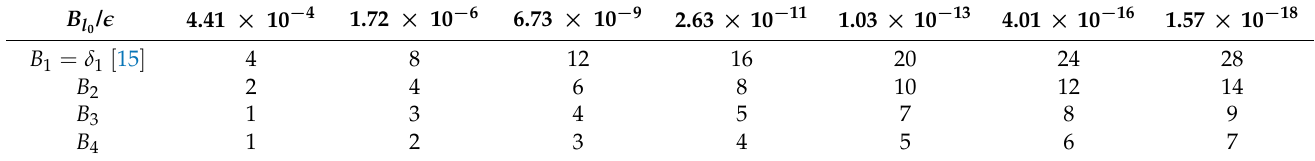
Table 3. Depth of a 4-point approximating QSS curve model.